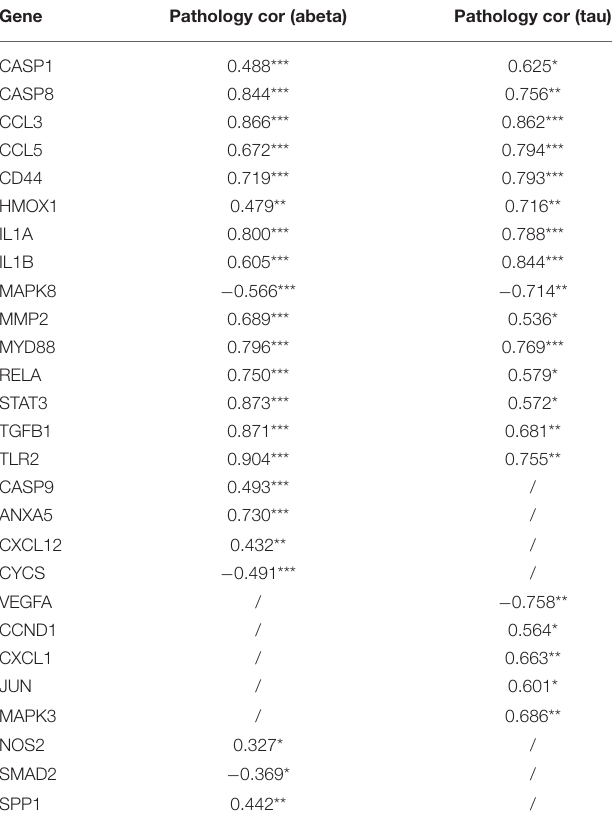
TABLE 2 | Analysis of correlation between common targets and A β and Tau proteins.